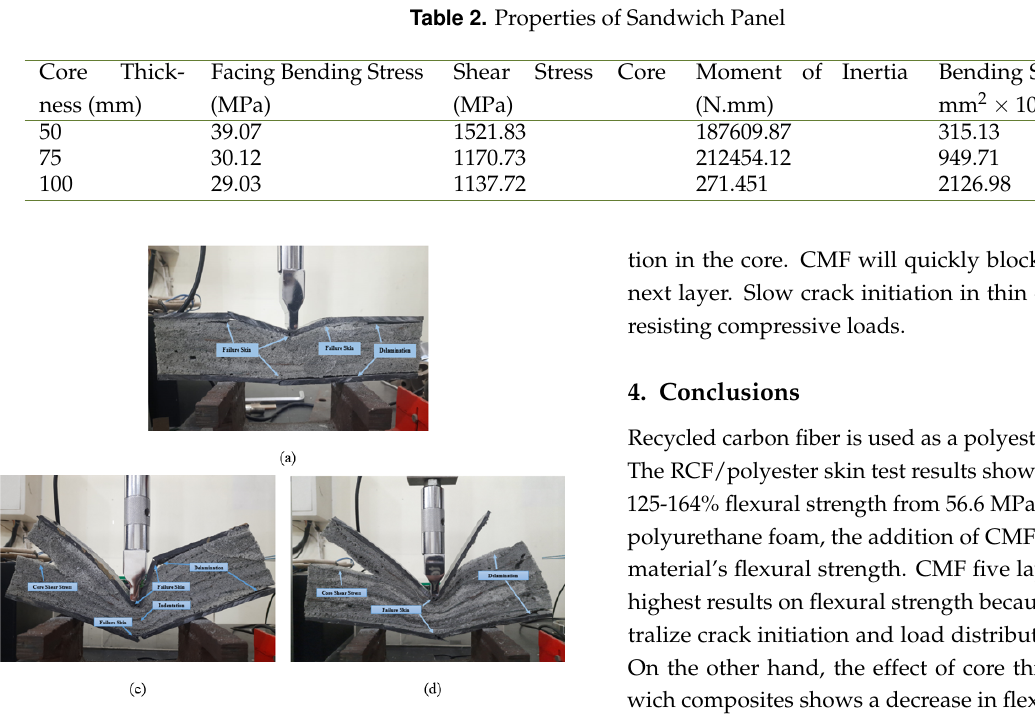
Fig. 9. The failure of Sandwich Panel with core thickness: (a) 50 mm; (b) 75 mm, and (c) 100